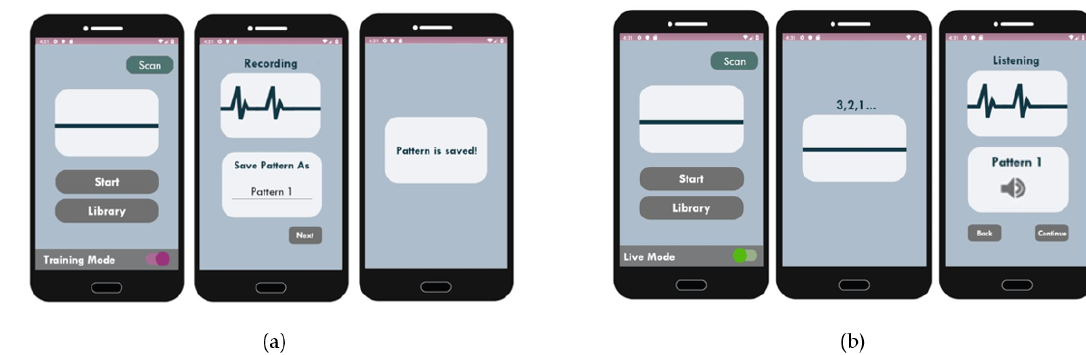
Figure 6. Examples of ( a ) training mode, and ( b ) live mode of continuous breath encoding for the storage and the retrieval of breathing patterns linked to a user phrase using a mobile